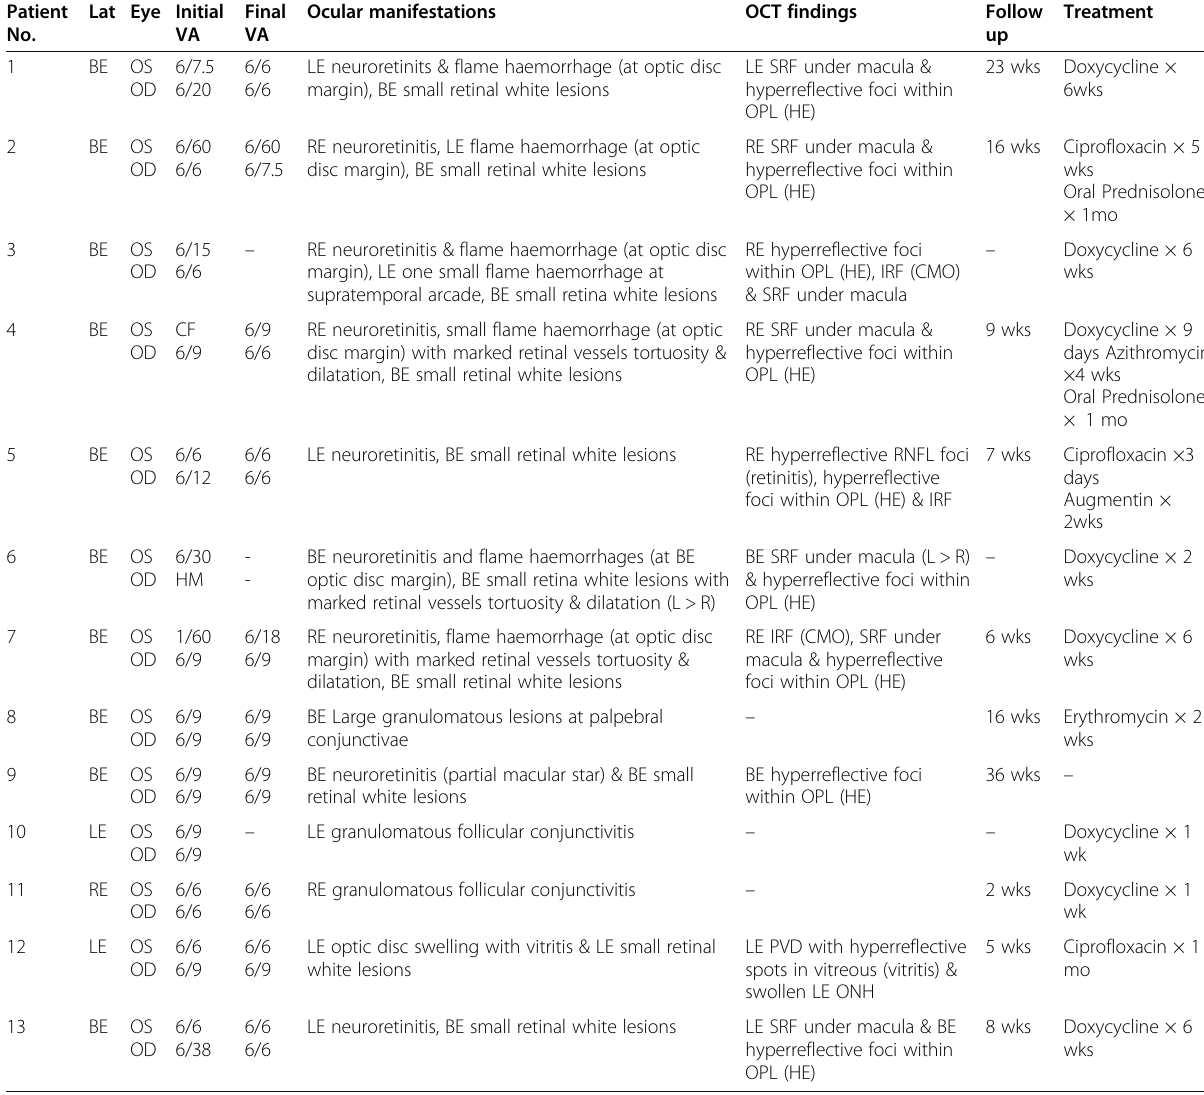
Table 2 Laterality, initial and final VA, ocular manifestations, OCT findings, follow-up duration and treatment Patient